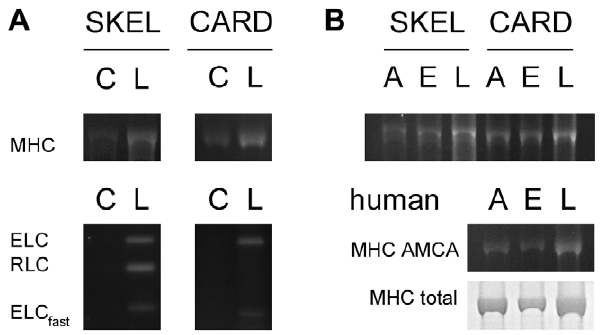
Figure 4. Myosin nitrosylated invivo and invitro . A: Rat skeletal and cardiac myosin heavy (MHC) and light chains were nitrosylated by in vitro exposure to SNO-L-cysteine (L) over the control level (C). The ventricular/slow skeletal isoform of the essential light chain (ELC) could be nitrosylated, as could the regulatory light chain (RLC) and fast essential light chain of skeletal muscle myosin. The regulatory light chain of cardiac myosin was not significantly nitrosylated. B: Myosin heavy chain was endogenously (E) nitrosylated in rat skeletal and cardiac muscle, and also in human myocardium (MHC AMCA). A protein staining of the same gel is shown (MHC total) to illustrate how nitrosylation is normalized against protein mass to reveal low levels of nitrosylation between zero (A, ascorbate-treated) and maximum (L, SNO-L-cys-treated). See the text for details of the normalization procedure. Without normalization, variations in recovery between protein bands (as shown, typical) will mask single (or a few) nitrosylated cysteines in large proteins like myosin. N=3 in all cases.